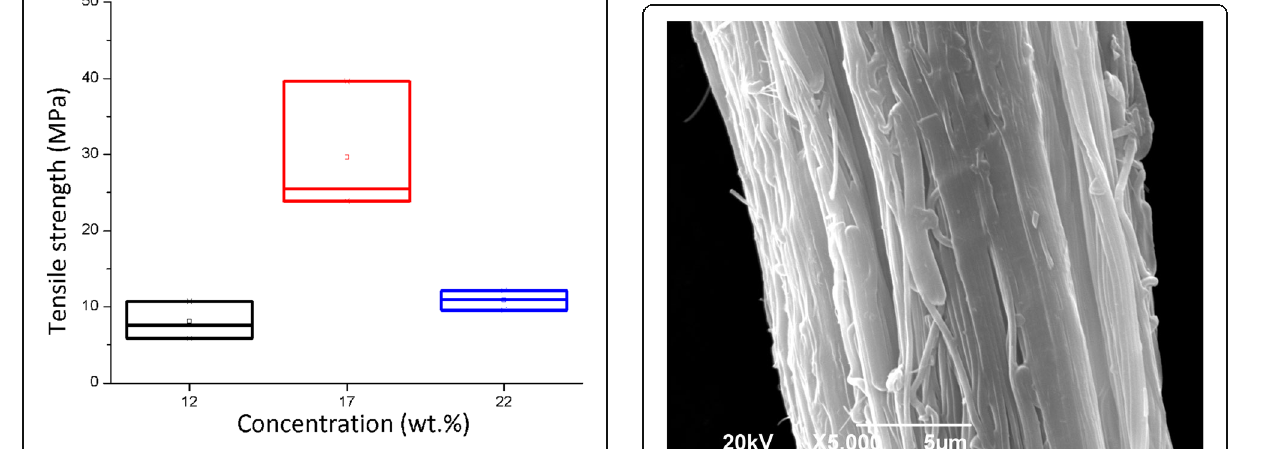
Fig. 6 Tensile strength of polyamide 6/66 nanofiber bundles at different concentrations Fig. 7 SEM image of the surface of PA 6/66 nanofiber